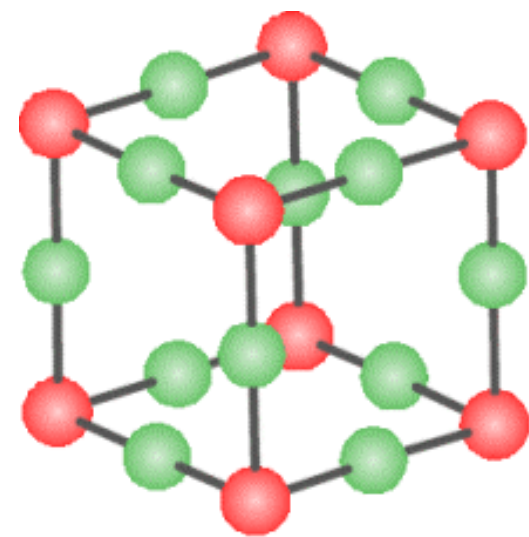
Table 1. Numerical values of the density, the longitudinal (vl), transverse ( v ) and average ( v ) elastic wave velocities, and the t m Debye temperature of Cu3N material obtained by Rahmati et al . [1].